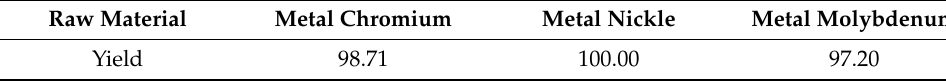
Table 5. Yield of alloy in vacuum reduction sintering process, wt %. Raw Material Metal Chromium